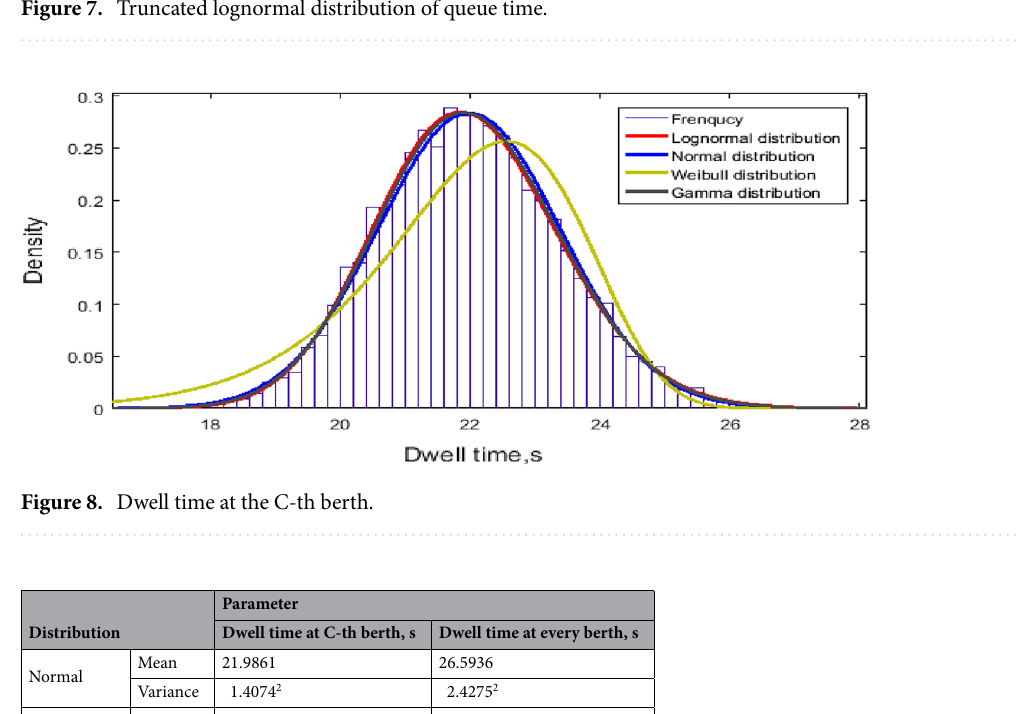
Figure 7. Truncated lognormal distribution of queue time.